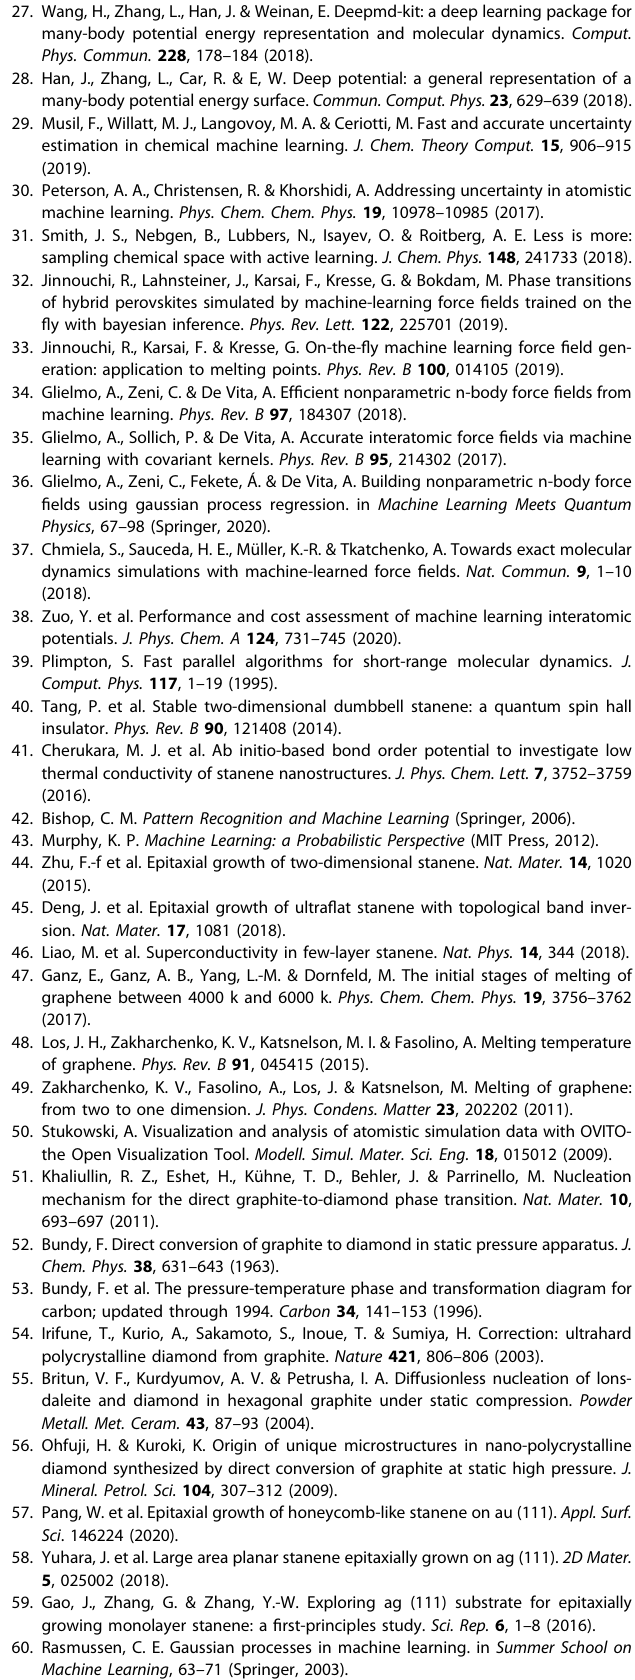
The algorithm for the MGP and mapped Bayesian active learning has been implemented in the open-source package FLARE 16 and is publicly available